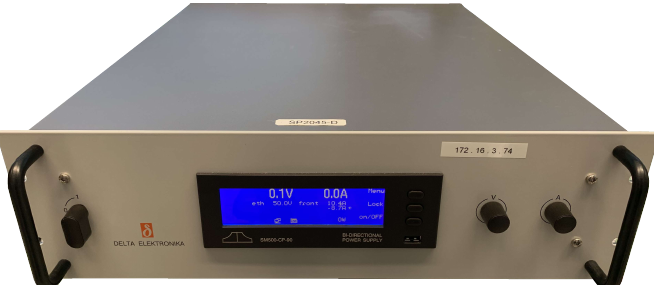
Figure 3. SM 500-CP-90 bidirectional power supply from Delta Elektronika, which is used to emulate the power electronic converters in low voltage dc